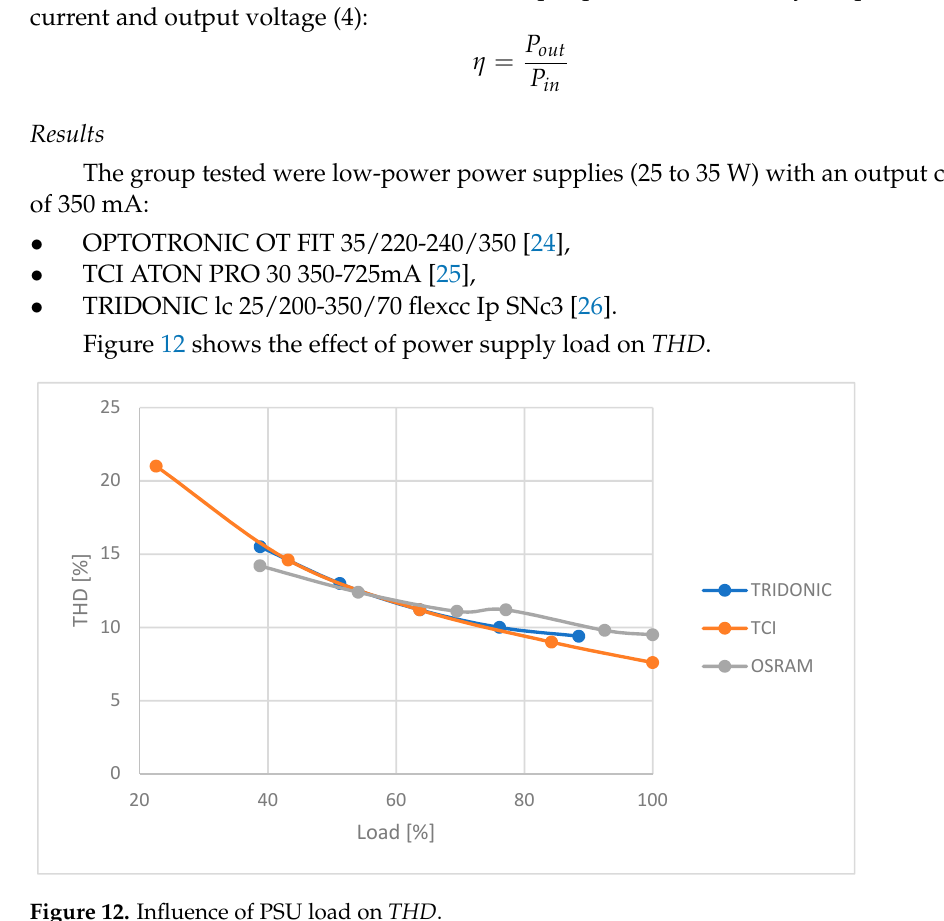
Figure 14. The influence of the power supply load on the efficiency. The best efficiency of the three power supplies tested is that of Tridonic, despite having the worst power quality parameters. The TCI power supply from the measurement at about 85% of the maximum load decreased its efficiency, which is consistent with the data sheet available on the manufacturer’s website. 8. Discussion In this study, attention was paid to non-linear low-power consumers, which include LED lamps. It was shown that the power supply systems of these compact light sources generate higher harmonic currents, the level of which far exceeds the permissible values, which in turn can adversely affect other electricity consumers.